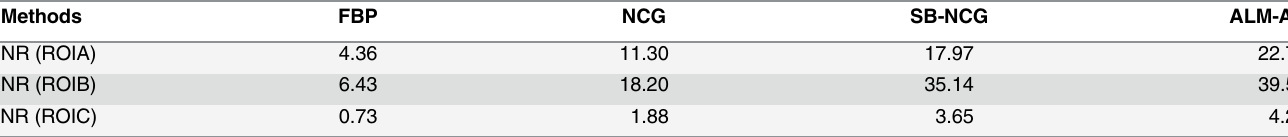
Table 2. CNRs of the images reconstructed by four different